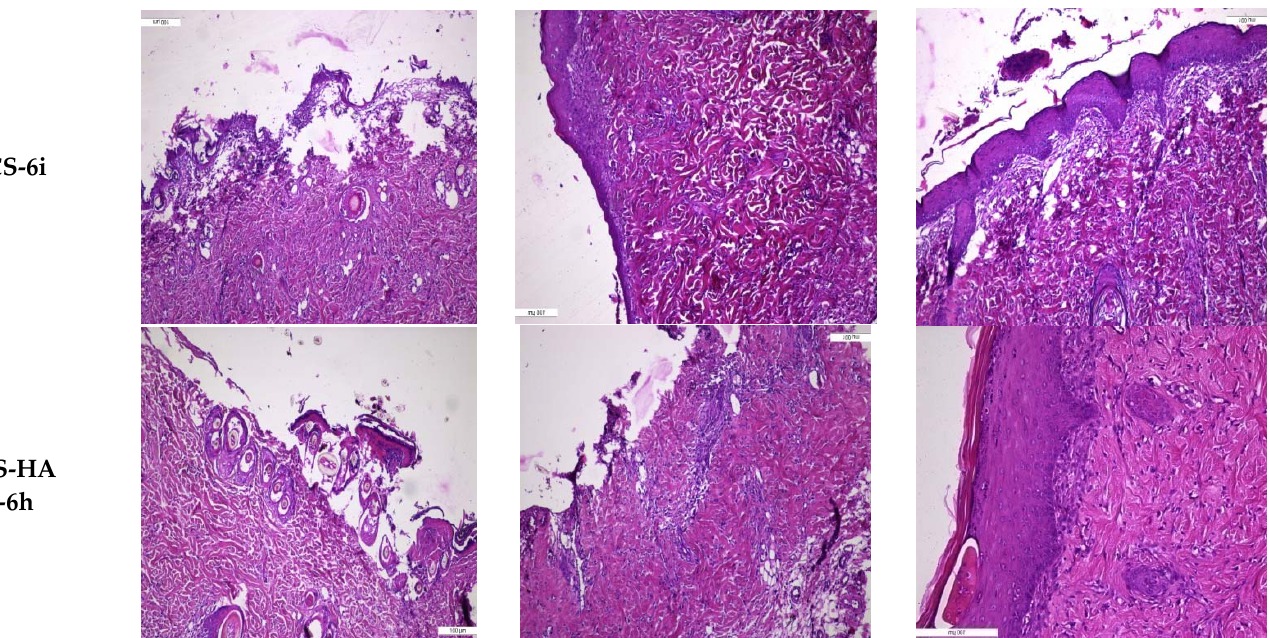
Figure 8. Macroscopic ( a ) and microscopic ( b ) evaluation of burn wound area of the polymer membranes and control at various timelines: on the 5th, 10th and 15th day of the experiment.